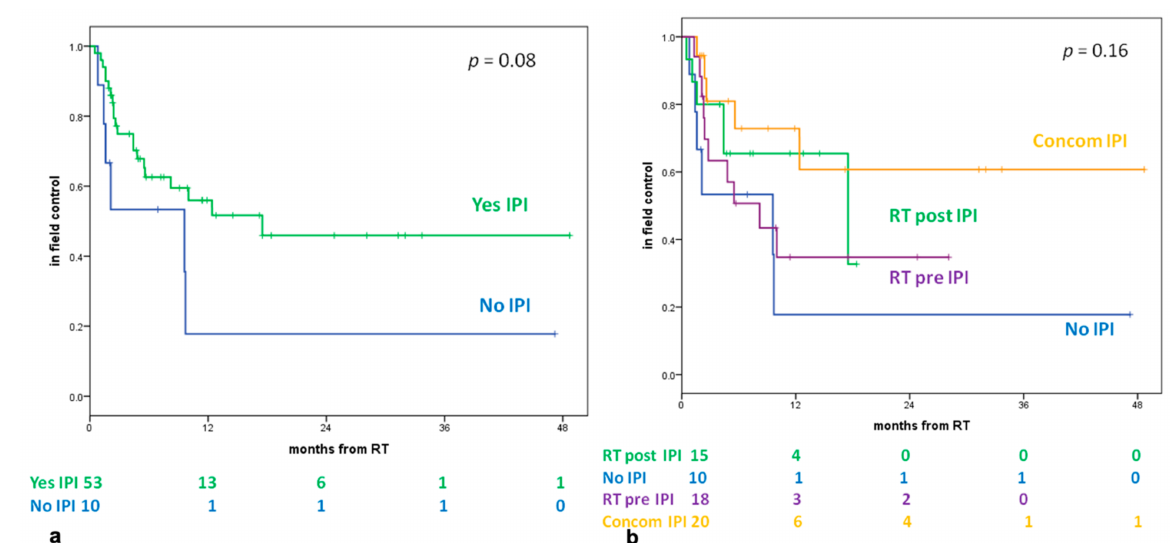
Figure 2. ( a ) Local control (in the SRS field) according to IPI. ( b ) Local control (in the SRS field) according to four